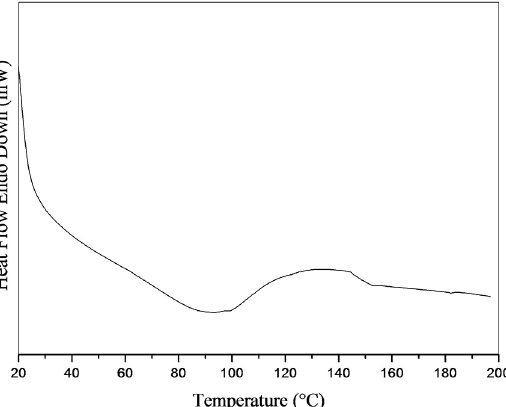
Figure 3: DSC thermogram of methylcellulose.